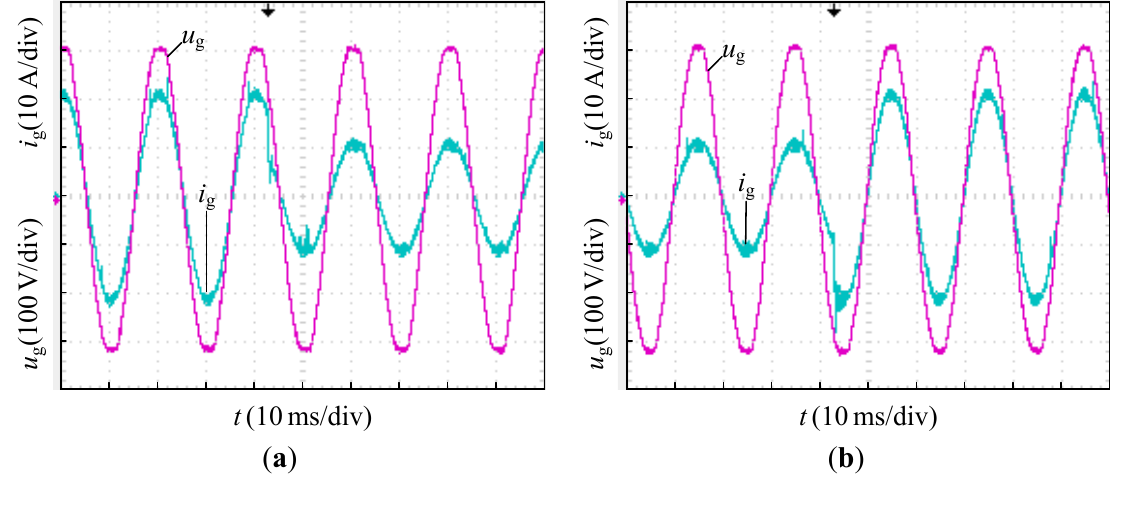
Figure 26. Dynamic response waveforms of grid voltage and current of BSS-FBC and typical two-stage topology: ( a ) Rated power to half power in the charging mode of BSS-FBC; ( b ) Half power to rated power in the charging mode of BSS-FBC; ( c ) Rated power to half power in the discharging mode of BSS-FBC; ( d ) Half power to rated power in the discharging mode of BSS-FBC; ( e ) Half power to rated power in the charging mode of typical two-stage topology; ( f ) Half power to rated power in the discharging mode of typical two-stage